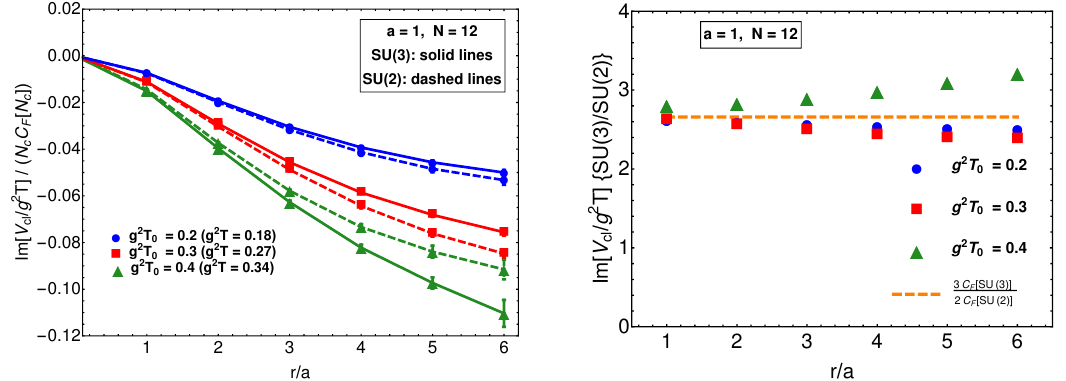
Figure 7 . Left: Im[ V cl ( r )] /g 2 T extracted from SU(2) and SU(3) lattice gauge theories simulated with the same values T 0 . The given values of T correspond to SU(3) . The potential is divided by C F N c of the respective gauge group. Right: the ratios of SU(3) to SU(2) results for Im[ V cl ( r )] /g 2 T for the same simulations. The orange dashed line corresponds to 8 / 3